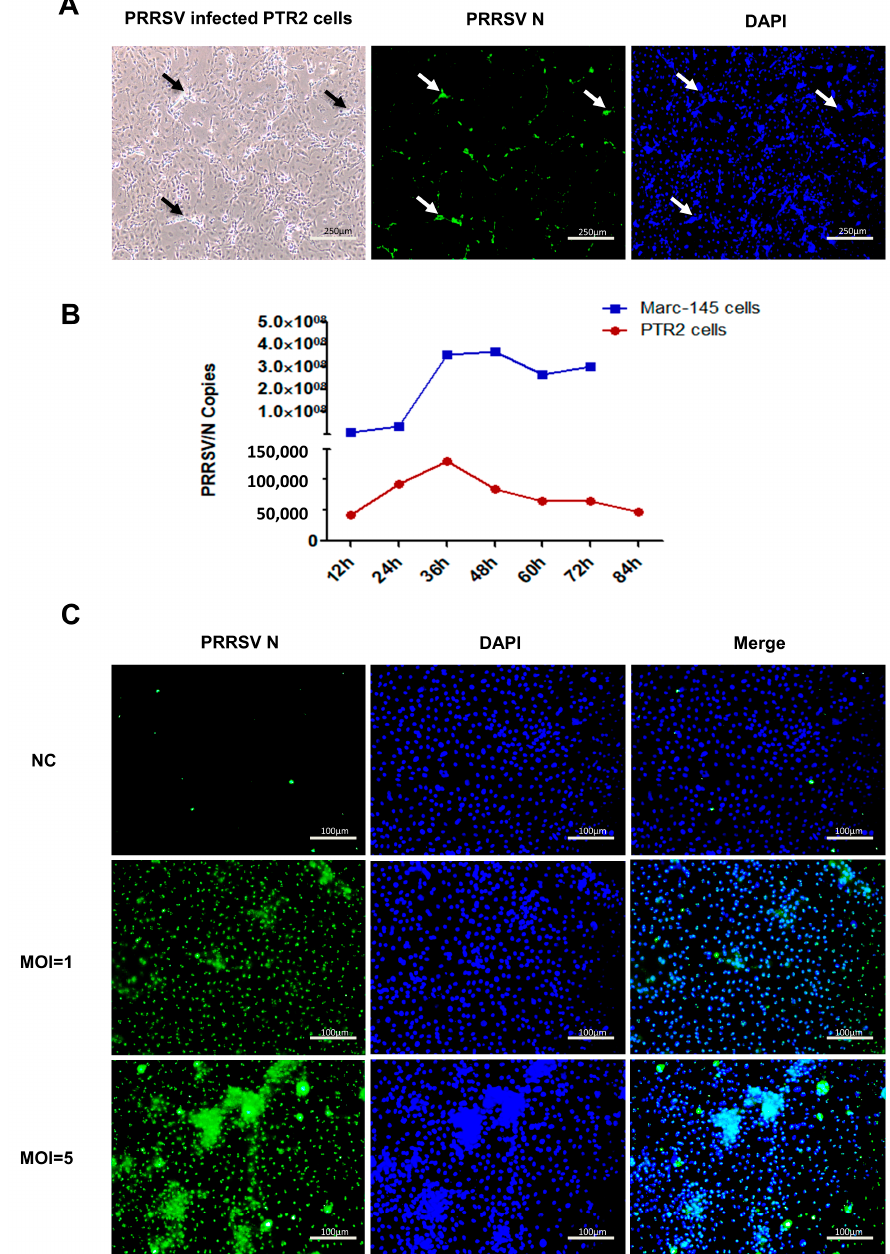
Figure 1. PRRSV infects the PTR2 cells. ( A ) The cell morphology and nuclear morphology of the PTR2 cells infected with PRRSV for 72 h. ( B ) PRRSV with MOI = 1 was inoculated in the MARC-145 cells and PTR2 cells, respectively, and the copy number of the N protein of PRRSV was detected by real-time fluorescence quantification at different time points. The susceptibility and viral load differences of the two cell lines were compared using a line graph. ( C ) The immunofluorescence assay was used to observe the expression of viral N protein in the PTR2 cells infected with PRRSV with MOI = 1 and MOI = 5 at 48 h.